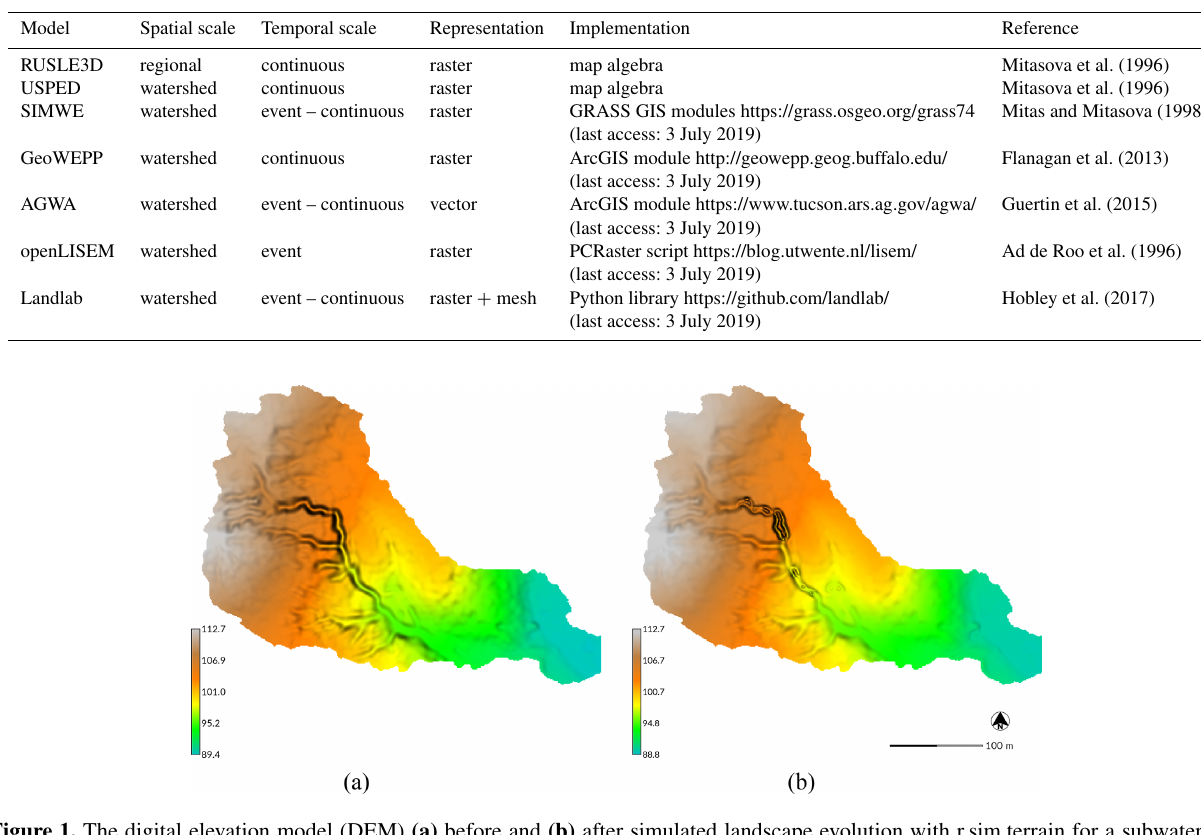
Figure 1. The digital elevation model (DEM) (a) before and (b) after simulated landscape evolution with r.sim.terrain for a subwatershed of Patterson Branch, Fort Bragg, NC, USA. The before DEM was generated from an airborne lidar data acquired in 2012. The simulation used the SIMWE model for a 120min rainfall event with 50mmh − 1 for a variable erosion–deposition regime at steady state. In the evolved DEM, the gully channel has widened with depositional ridges forming along its